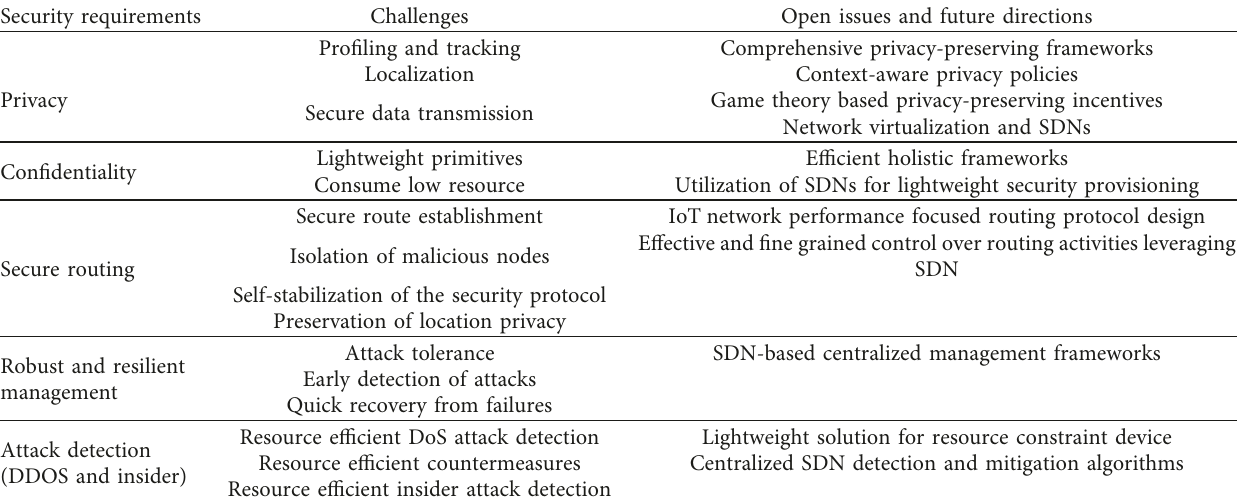
Table 1: Comparison of challenges and open/future issues for different security requirements in IoT